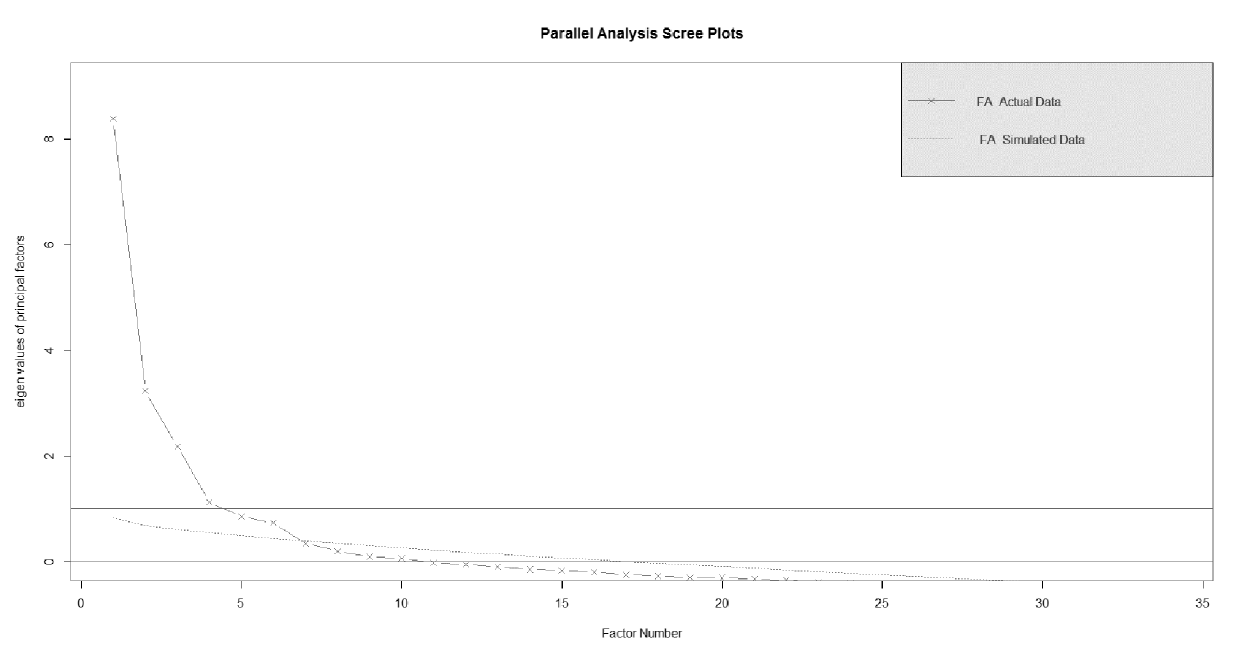
Figure B1. Scree plot of parallel analysis.